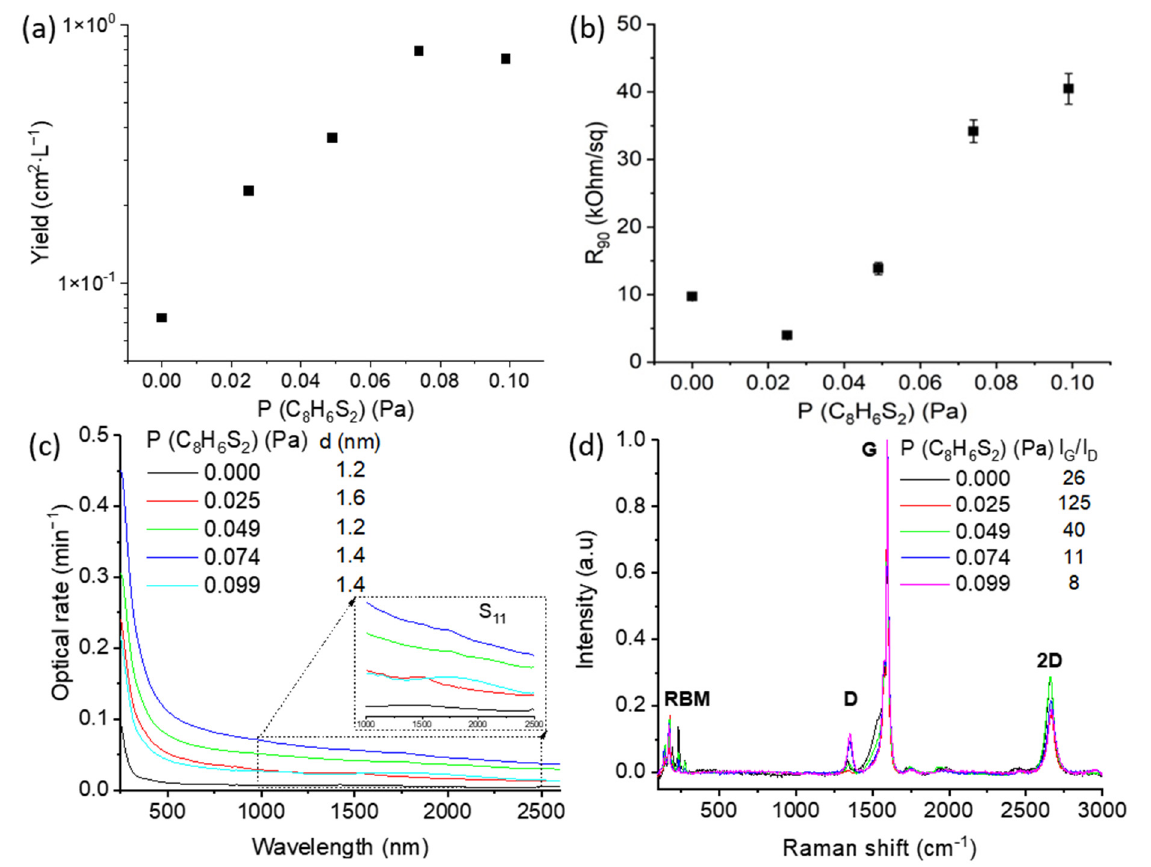
Figure 2. ( a ) In fl uence of bithiophene on SWCNT deposition rate, ( b ) equivalent sheet resistance, ( c ) UV-vis-NIR, and ( d ) Raman spectra for SWCNTs obtained with di ff erent bithiophene contents; RBM ( c ) UV-vis-NIR, and ( d ) Raman spectra for SWCNTs obtained with different bithiophene contents; stands for radial breathing modes—a fi ngerprint of SWCNTs. RBM stands for radial breathing modes—a fingerprint of